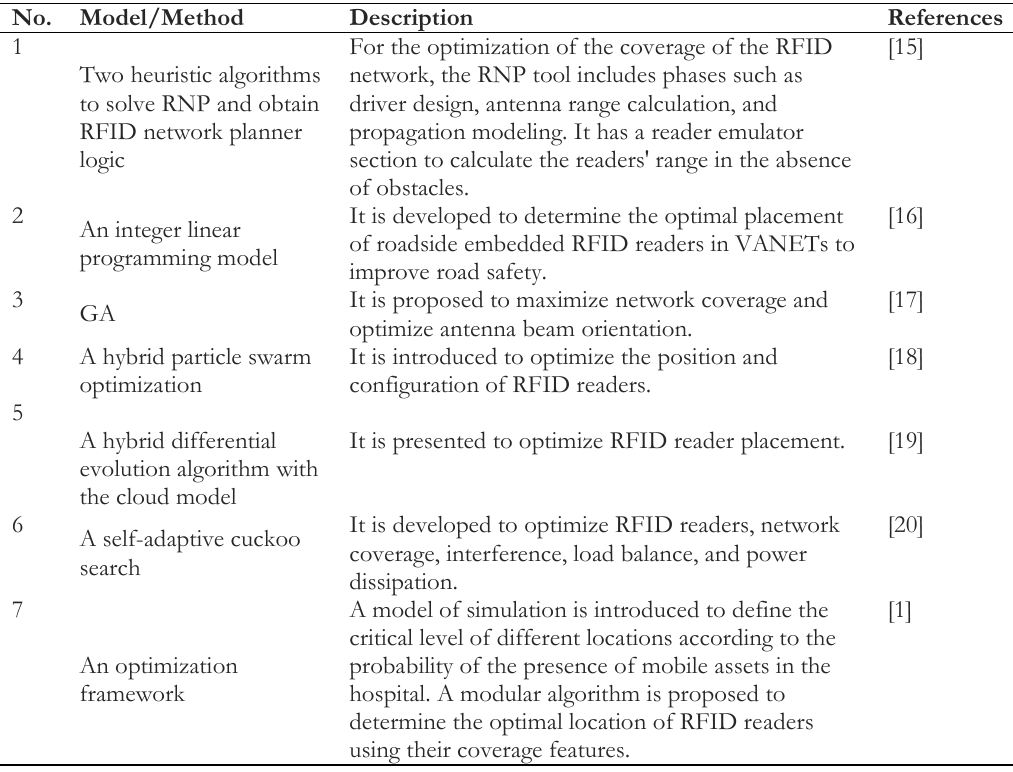
Table 1. List of existing studies in